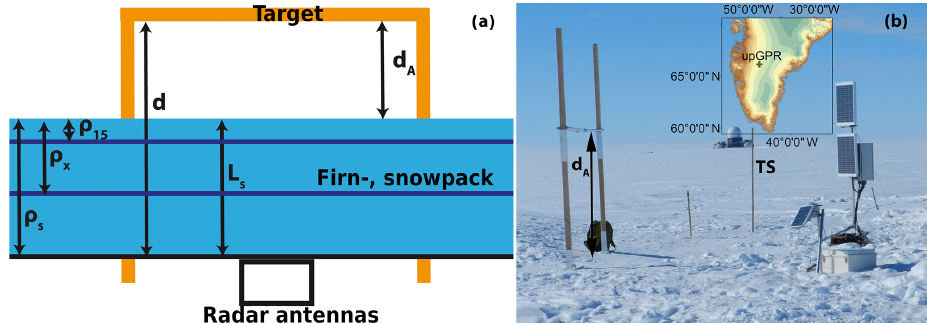
Figure 1. Sketch and image of the radar arrangement for Dye 2. (a) Sketch of the installations above and beneath the snow surface. ρ i indicate the density of specific snow layers, L s indicates the whole firn and snow column above the antennas and d A , d indicate distances. (b) Image of the above snow installations at the research site Dye-2. The inset displays the location of the upGPR for the southern half of Greenland. The color coding for the inset map represents 250m contour lines with the digital elevation model generated from Howat et al. (2014). TS in (b) represents the location of the thermistor